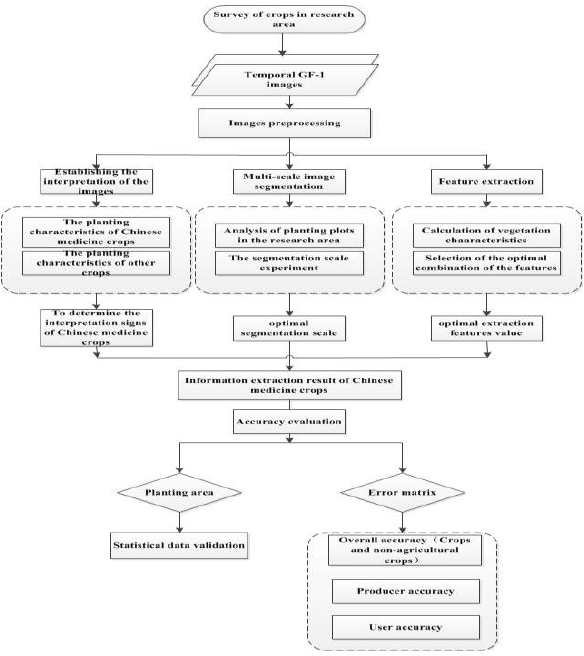
Figure 3 .The overall technical roadmap